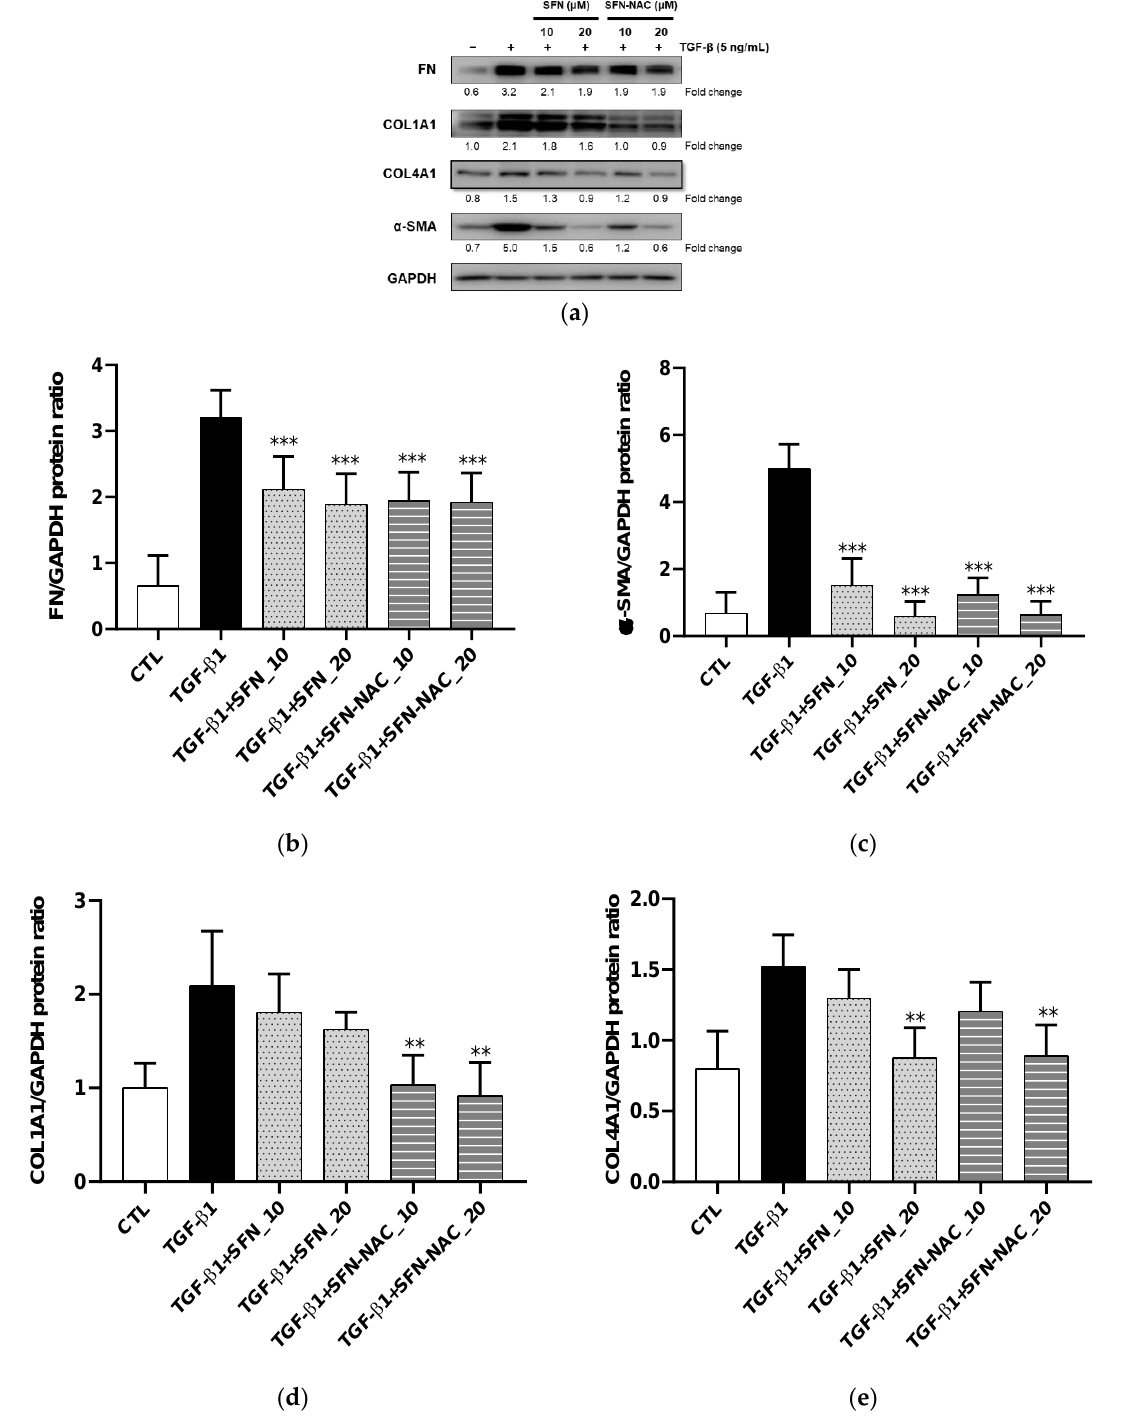
Figure 4. Effect of SFN and SFN-NAC treatment on the expression of ECM proteins and myofibroblast marker following TGF- β 1-induced fibrosis in MRC-5 fibroblast cells. The cells were pre-treated for 1 h with the indicated concentrations of SFN and SFN-NAC, followed by treatment with TGF- β 1 (5 ng/mL) for 48 h. ( a ) Western blot analysis for FN, α -SMA, COL1A1 and COL4A1. Densitometry of Western blotting of FN ( b ), α -SMA ( c ), COL1A1 ( d ), and COL4A1 ( e ). Data are expressed as the mean ± standard deviation of at least three different experiments. ** p < 0.01, *** p < 0.001 versus TGF- β 1 induction. ECM, extracellular proteins; TGF- β 1, transforming growth factor- β 1; SFN, sulforaphane; SFN-NAC, sulforaphane N -acetylcysteine; CTL, control; FN, fibronectin; α -SMA, alpha-smooth muscle actin; COL1A1, type I collagen; COL4A1, type IV